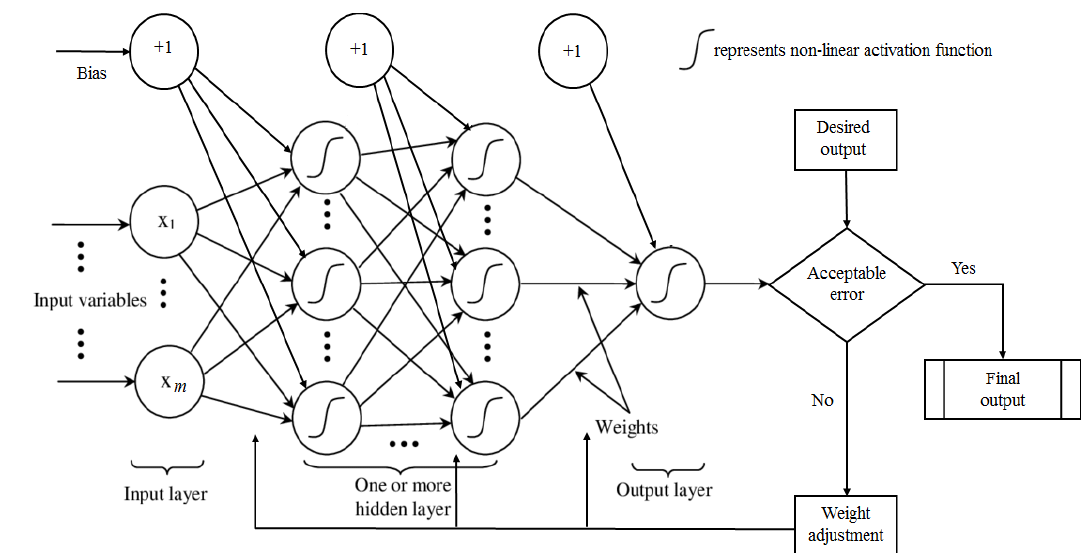
Figure 3. A typical MLP network with